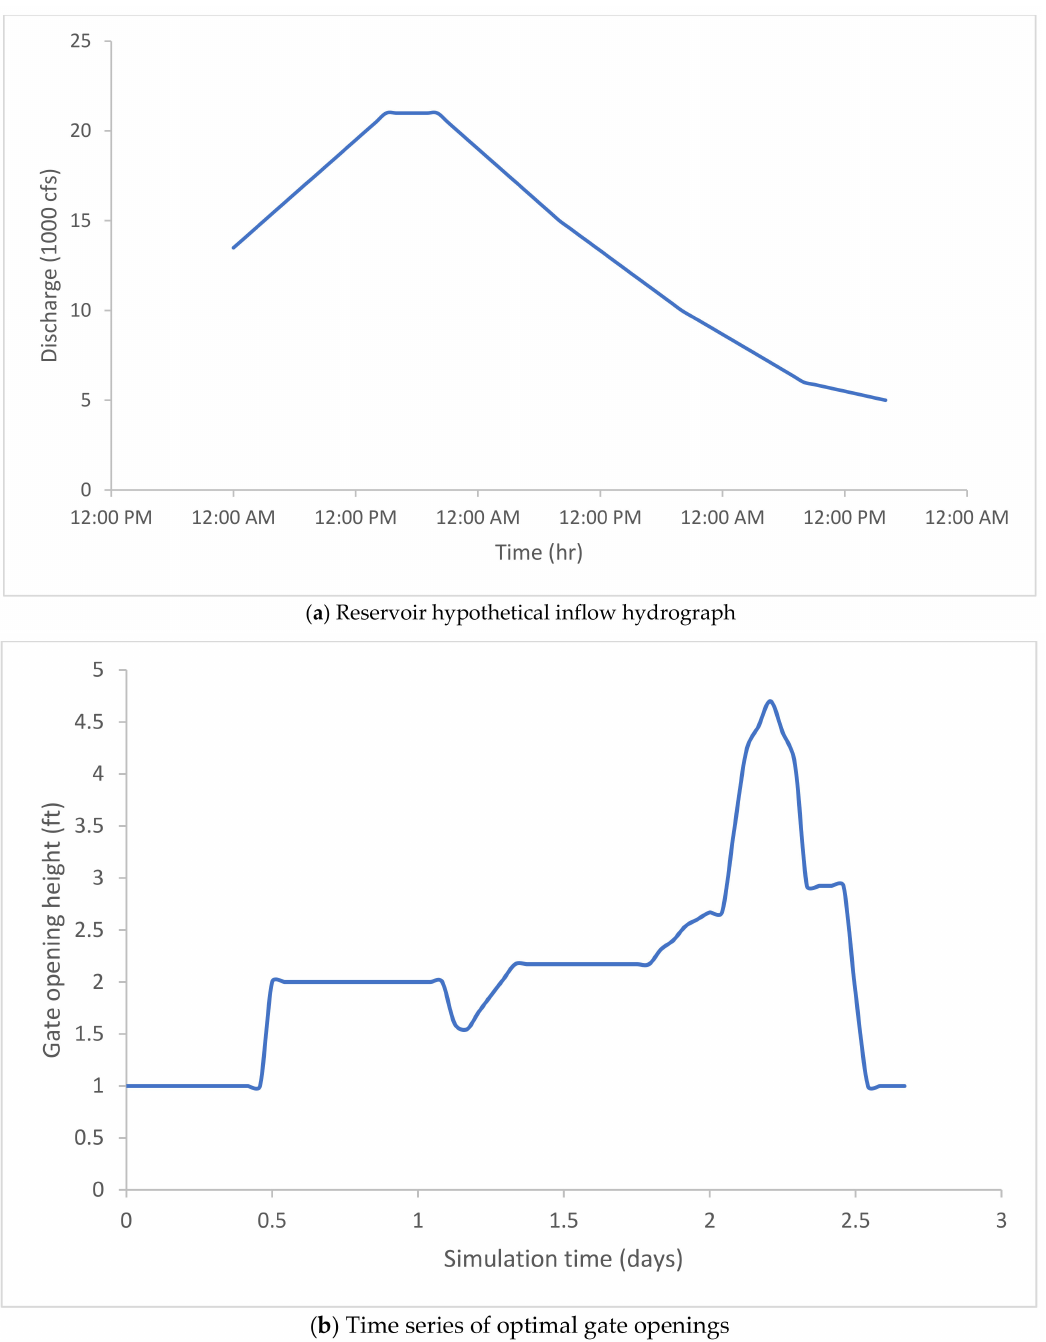
Figure 6. Inflow hydrograph and optimal gate openings.( a ) Reservoir hypothetical inflow hydrograph, ( b ) Time series of optimal gate